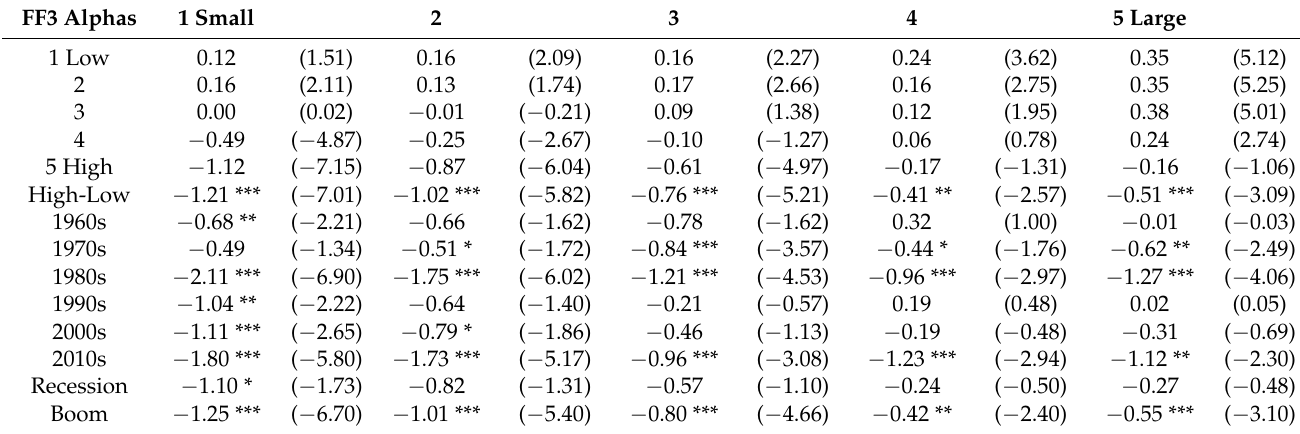
Table 3. Portfolio sorting analysis. This table shows the results of portfolio sorting analysis for the period of July 1963 to December 2019. Stocks are first sorted into five size quintile portfolios and then each size quintile is further sorted into five quintiles based on idiosyncratic risk. As a result, it gives the equally weighted returns of 5 × 5 portfolios. Under each size quintile, yield by buying the portfolio with the high idiosyncratic risk and short selling the one with the low idiosyncratic risk is calculated. The equally weighted Jensen’s alphas from the Fama–French three-factor model are reported. The periods of economic recession and boom are from NBER business cycle dates. The t-statistics are in parentheses. *, ** and *** denote the statistical significance level at 10%, 5% and 1%,